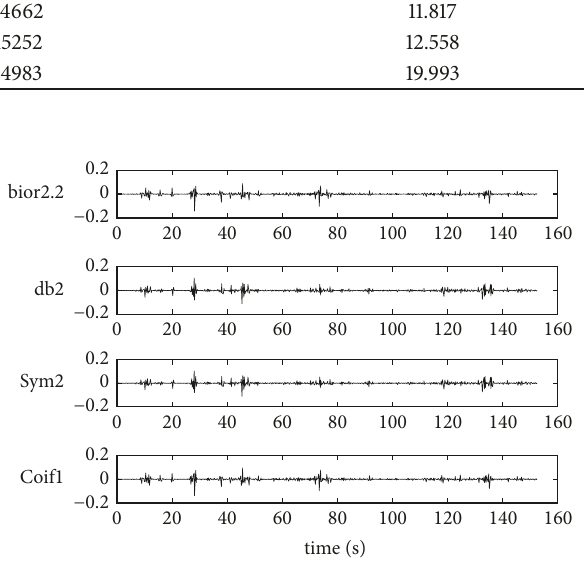
Figure 8: Detail coefficients of the envelope method with different wavelets.